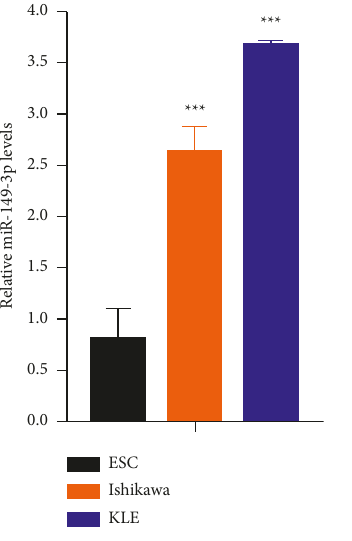
Figure 11: Expression of miR-149-3p in human endometriotic stromal cells (ESC), UCEC cell lines Ishikawa and